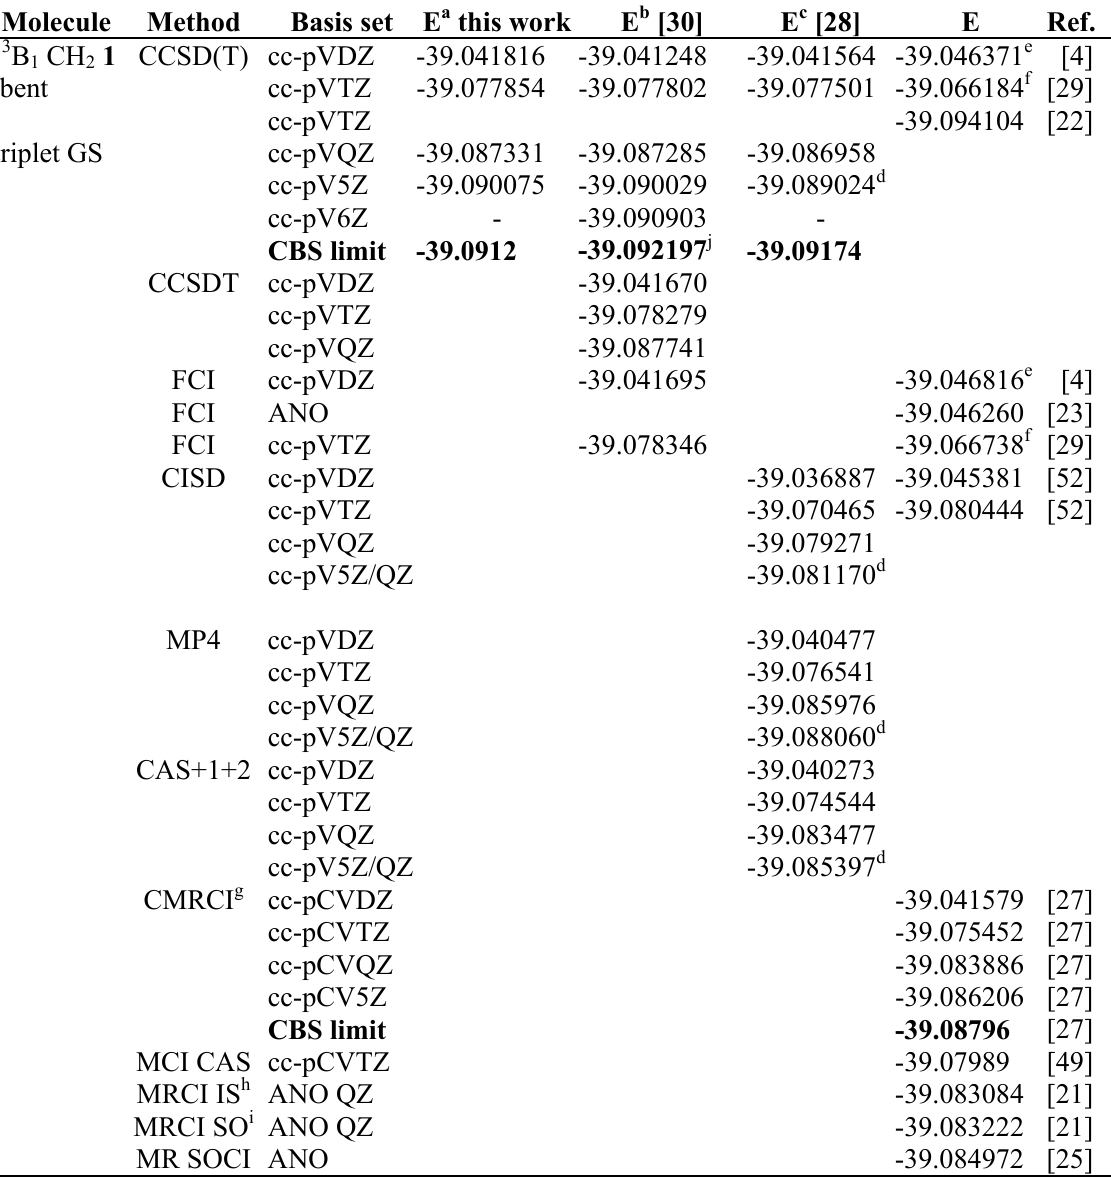
Table 1. Post-HF frozen-core calculations of total energies [Hartree] with Dunning basis sets for triplet methylenes 1 and 2. Own CCSD(T) calculations with exponential TQ5 CBS limits via eqn. 1 and literature data for different